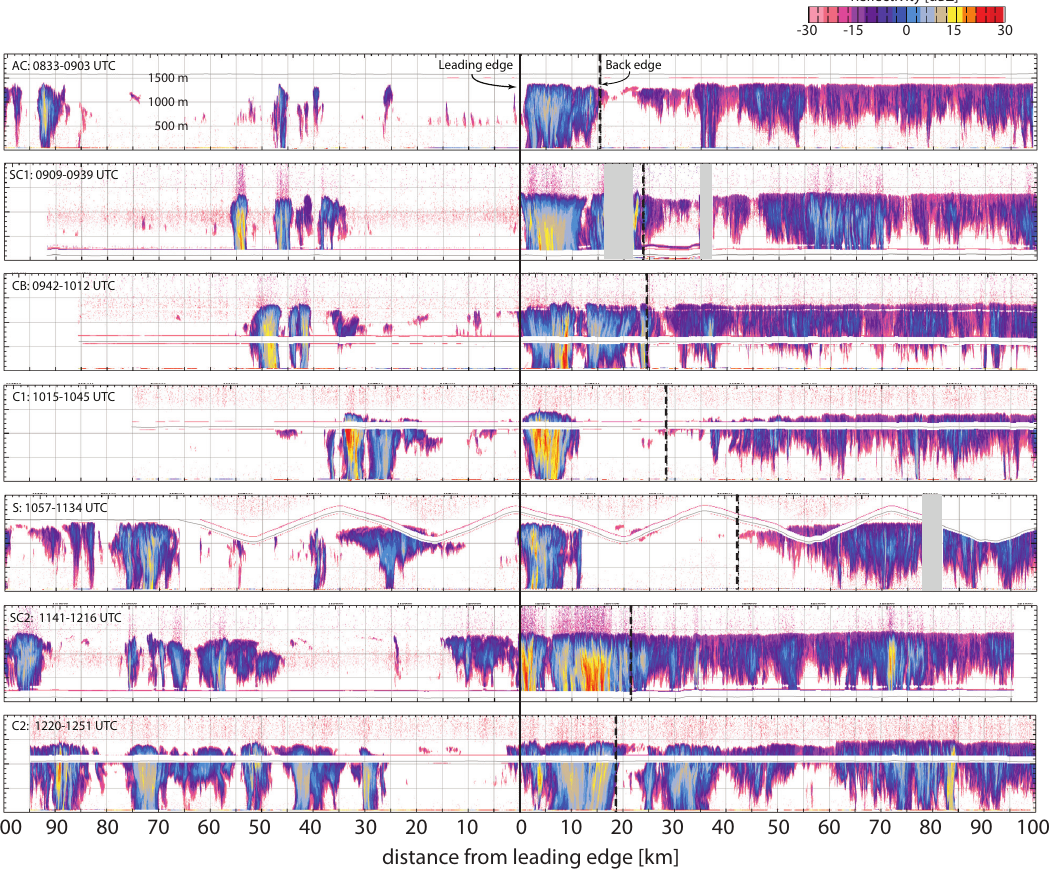
Fig. 5. Radar cross sections from the WCR for all legs in RF06. Runs are presented in time order (earliest at top). Gray regions denote periods when WCR was not functional.